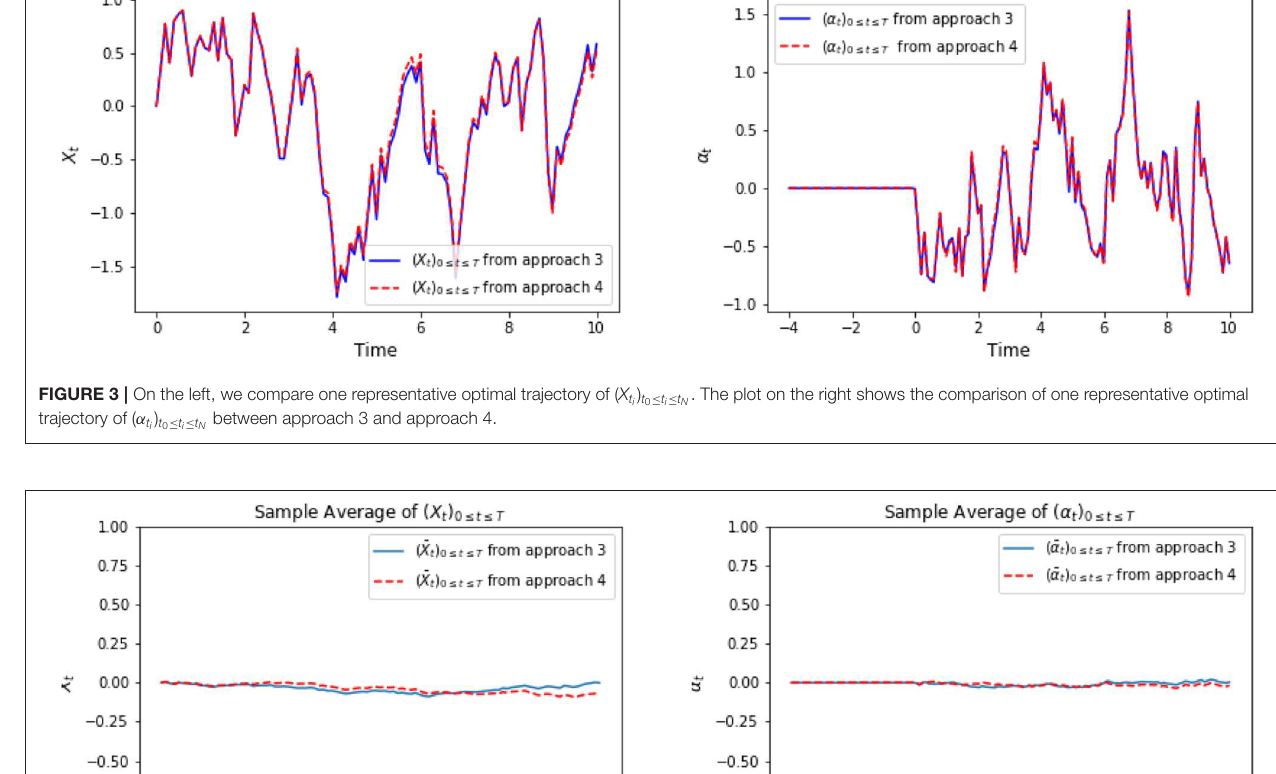
) t . The plot on the right shows the comparison of sample mean of trajectories i 0 ≤ t i ≤ t N